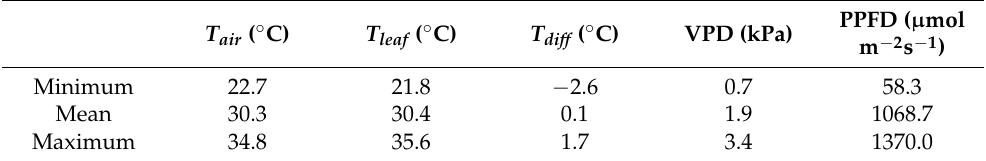
Figure 5. The basic structure of the plant-response-based strategy for irrigation and environmental controls for greenhouse tomato seedling cultivation. Table 4. Descriptive statistics used to verify the g sw status model and the whole system. Data were collected by the transparent leaf chamber from regularly watered plants.